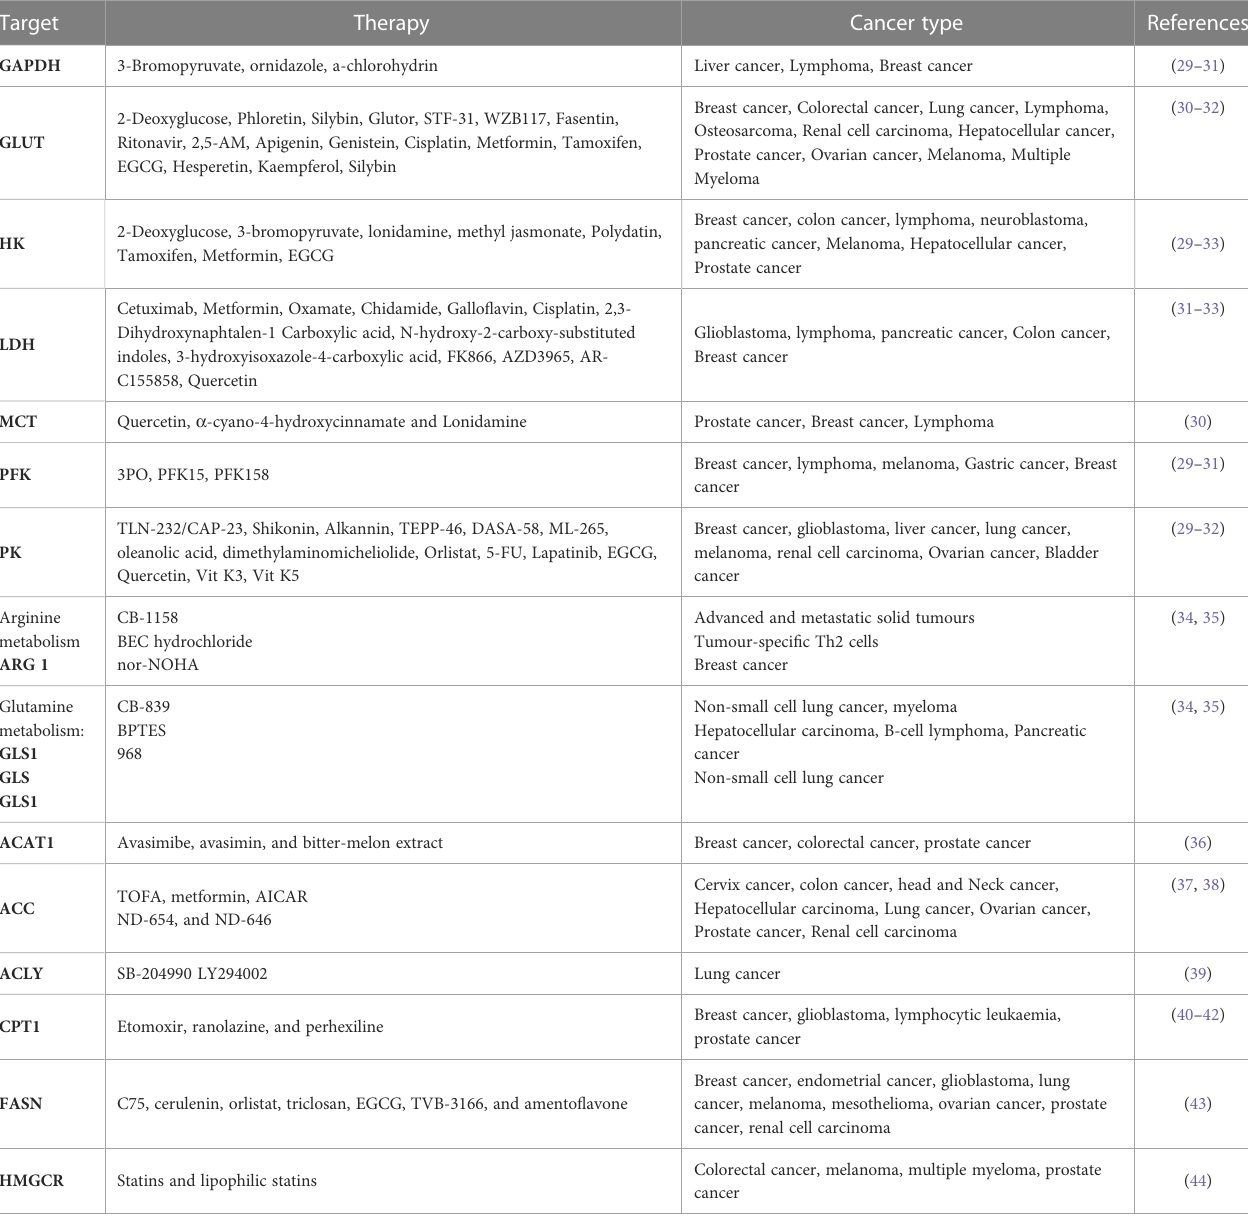
TABLE 1 Summary of anticancer drugs targeting Carbohydrate, Amino acid and Fatty acid metabolism.